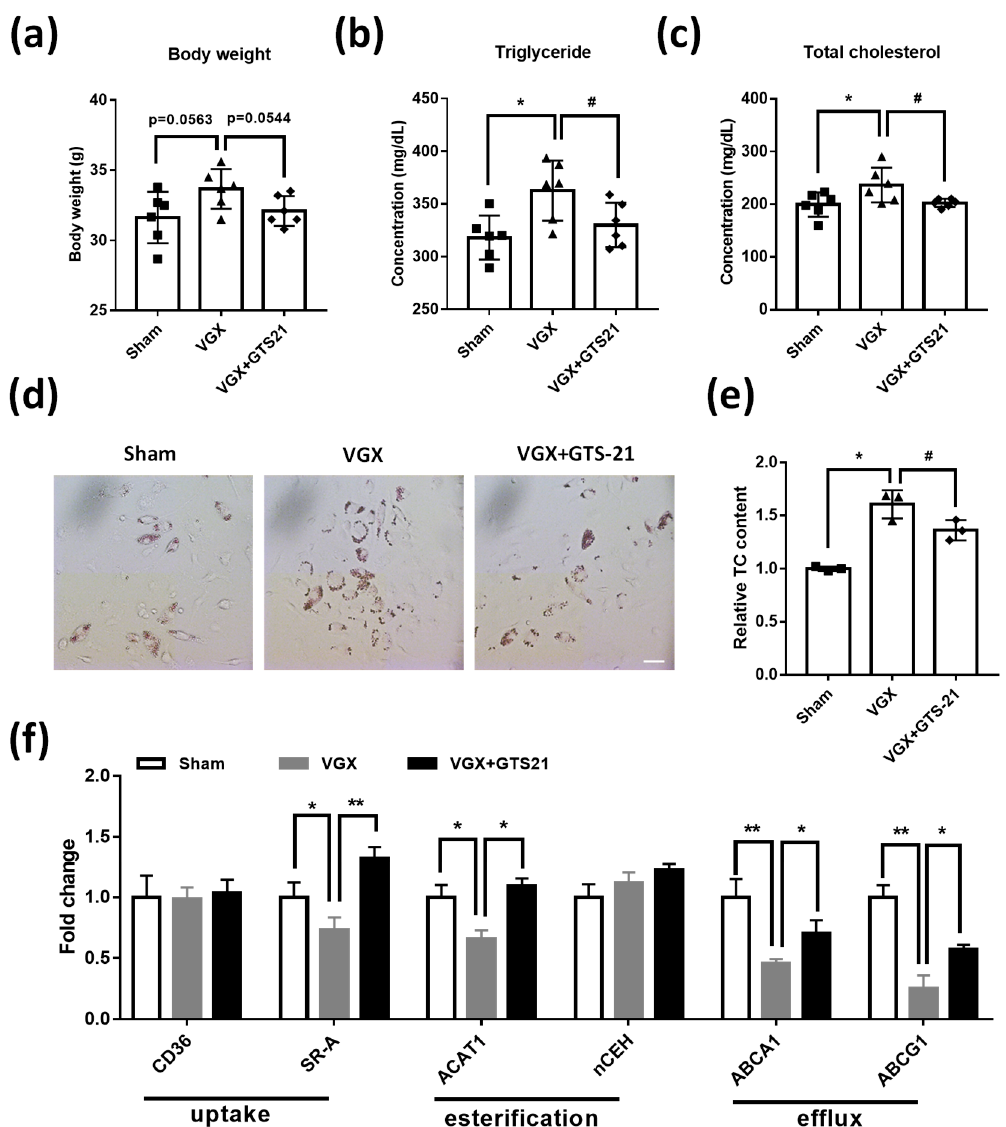
Figure 5. Effects of CAP activity on macrophage cholesterol metabolism in vivo. ( a – c ) The mice body weight ( a ), serum cholesterol ( b ), and triglyceride ( c ) were measured in the three groups of experimental mice, i.e., sham, VGX, and VGX + GTS-21. Data are presented as means ± SD ( n = 6 mice). * p < 0.05 as compared to sham; # p < 0.05 as compared to VGX; ns indicates not significant. ( d ) The thioglycollate-elicited peritoneal macrophages were isolated from sham, VGX, and VGX + GTS-21 mice and then subjected to Oil-red O staining. Scale bar represent 50 µ m ( n = 20 image field). ( e ) Quantitative analysis cholesterol content in peritoneal macrophages isolated from the three experimental mice. Data are presented as means ± SD ( n = 3 biological replicates). * p < 0.05 as compared to sham; # p < 0.05 as compared to VGX. ( f ) The mRNA expression analysis of genes associated with cholesterol metabolism in peritoneal macrophages isolated from the three experimental mice. Data are presented as means ± SD ( n = 3 biological replicates). * p < 0.05, ** p < 0.01 as compared to macrophage isolated from VGX mice.